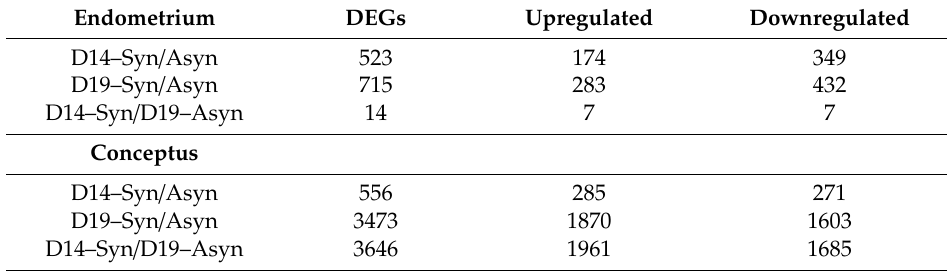
Figure 2. Venn diagram for the overlap of DEGs in the endometrium among three pair-wise comparisons, day 14 of conceptus development between synchronous (day 14 endometrium) and asynchronous (day 9 endometrium; D14 syn/asyn), on day 19 of conceptus development between synchronous (day 19 endometrium) and asynchronous (day 14 endometrium; D19-syn/asyn) and between day 14 synchronous and day 19 asynchronous pregnancies (D14-sync/D19-asyn). The numbers of DEGs in each compartment is depicted. Table 1. The number of genes differentially expressed (DEGs) in the endometrium and conceptus membranes on day 14 and 19 of development following transfer of day 8 horse embryos to day 8 (synchronous) or day 3 (asynchronous) recipient mares. Genes with higher expression in the synchronous compared to the asynchronous pregnancies are referred to as upregulated and those with a lower expression are referred to as downregulated.